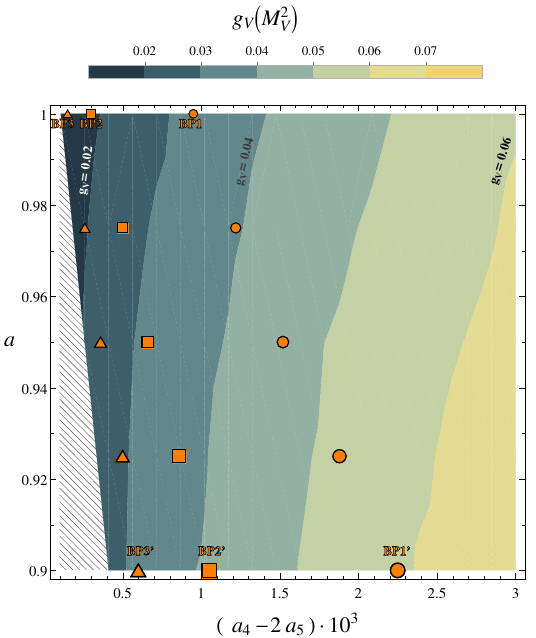
2 ) as a function of a and ( a 4 V ( M V